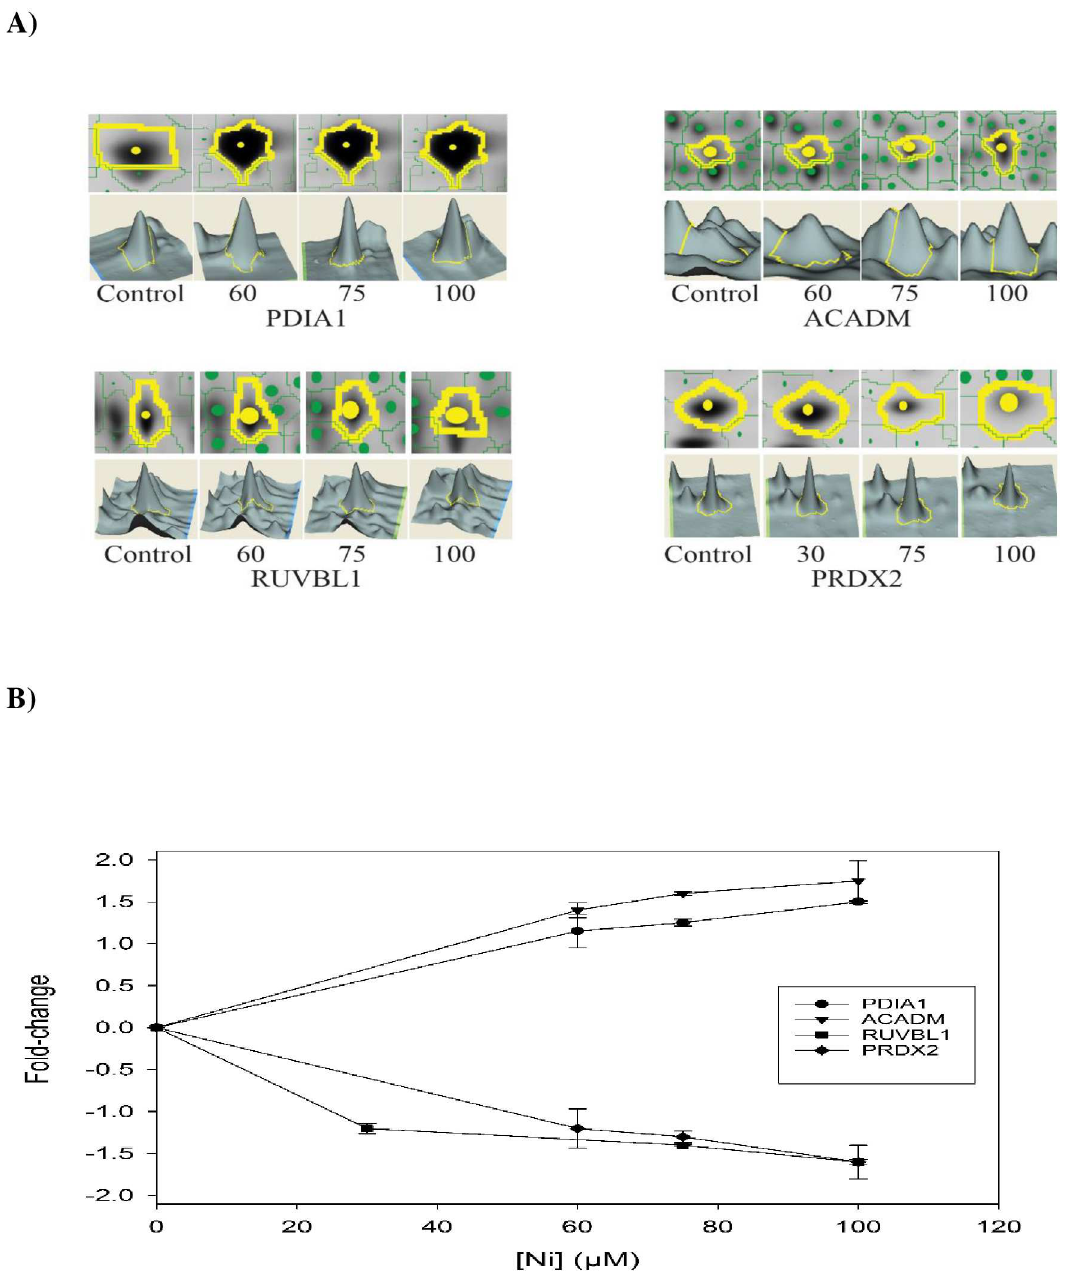
Fig 4. Fourrepresentative proteins,PDIA1,ACADM, RUVBL1, PRDX2 identified using2-DE profilingwere either increasedor decreased in a concentrationresponsive manner. A) The upperpanel is an expanded view of 2-DE gel imagesfor each proteinspot, and the lower panel is a 3D view of the proteinspot. The volume of each spot was calculated using Decyde softwareand is graphicallyrepresented. The expression level of the proteinis proportional to the volume of the peak. B) The line graphs indicatethe dose-responsive changes of proteinsin BEAS-2B cells treatedwith 4 different concentrations of Ni (II).Statisticaldifferences in expression of these proteinsbetween Ni (II)treatedand controlgroup were determinedby Studentt-test(n = 3, p <